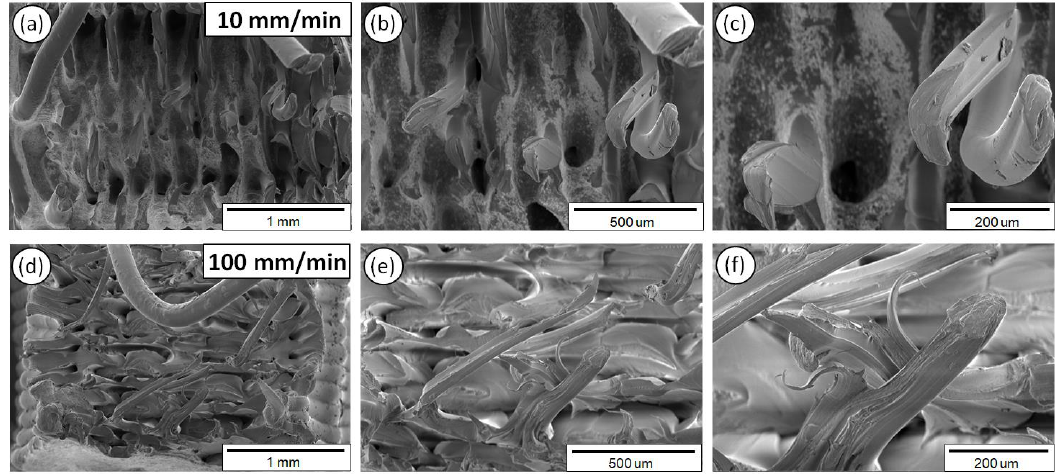
Figure 10. SEM images of PETG fractured surfaces at three di ff erent magnifications for the 10 ( a – c ) and 100 mm / min ( d – f ) strain rates.